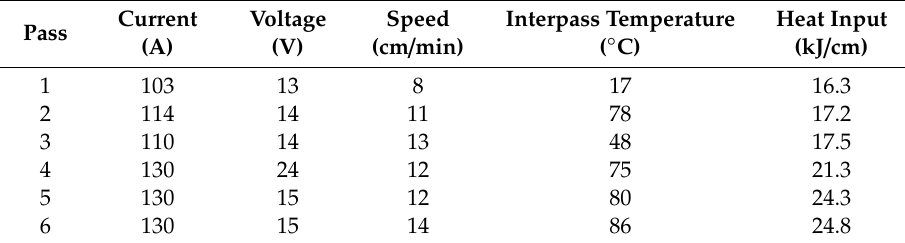
Table 3. Welding conditions of ER316L filler